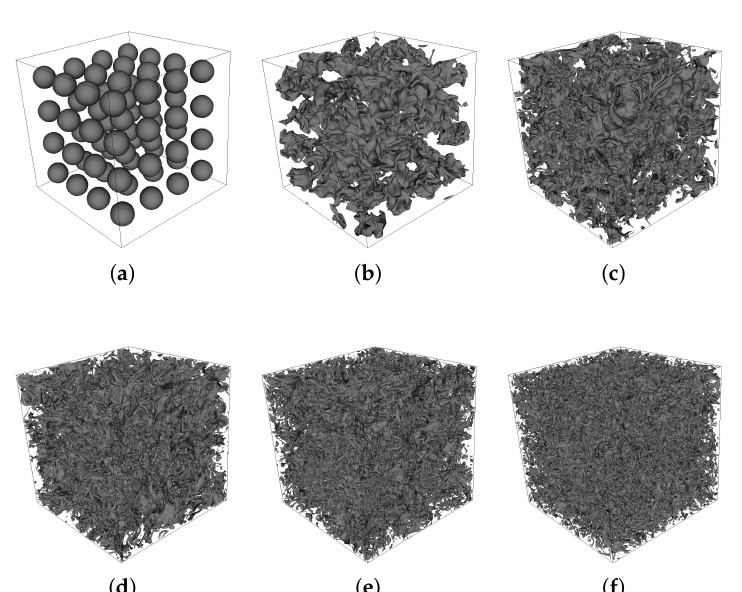
Figure 2. Visualization of the emulsification process of the reference case, from t / τ = 0 to t / τ = 2.0. ( a ) t / τ = 0; ( b ) t / τ = 0.25; ( c ) t / τ = 0.5; ( d ) t / τ = 0.75; ( e ) t / τ = 1.0; ( f ) t / τ = 2.0.